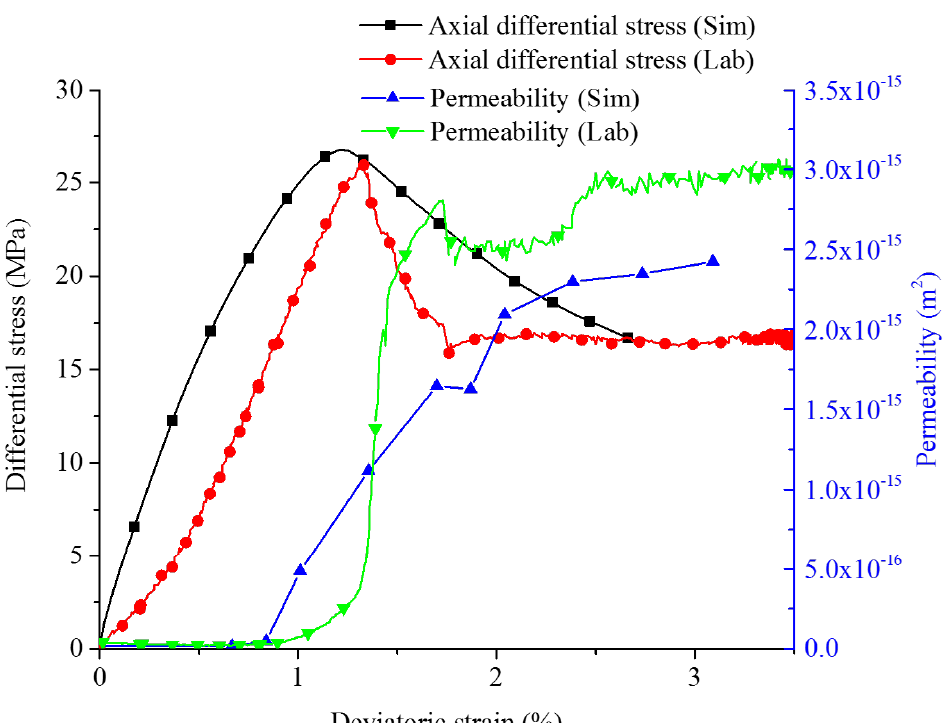
and pore pressure distribution [Pa].